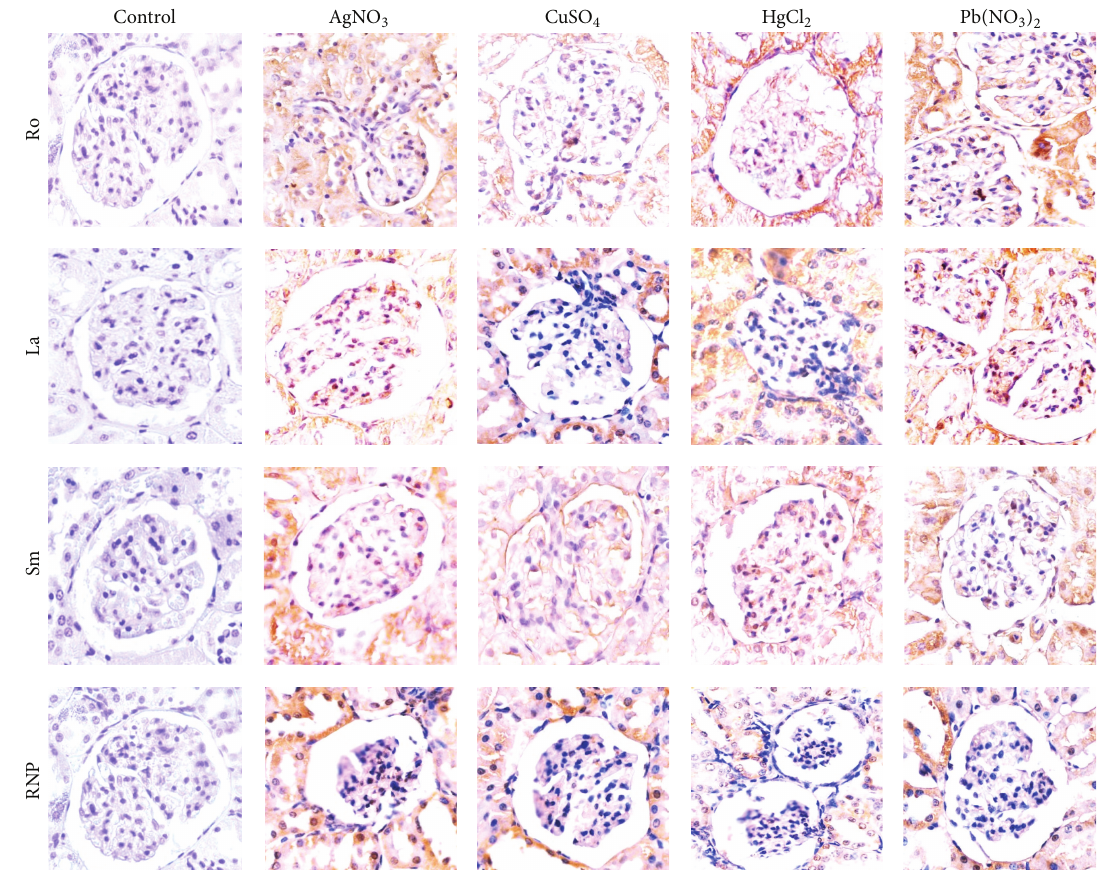
Figure 5: Immunohistochemistry of kidneys demonstrating the overexpression of ribonucleoproteins induced by heavy metal salts. Note that at the beginning of the trial (control), the expression is faint or absent, whereas at the end of the intoxication trial, ribonucleoprotein expression notably